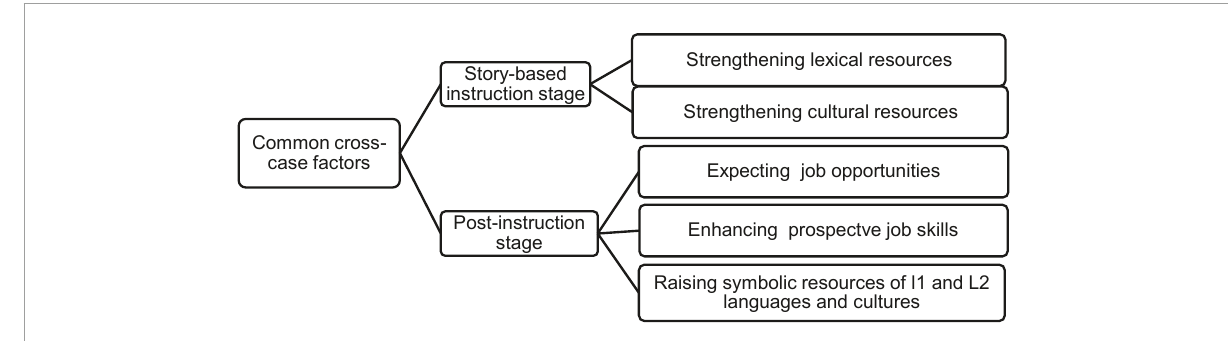
FIGURE2 Common factors affecting language investment in the story-based phases.